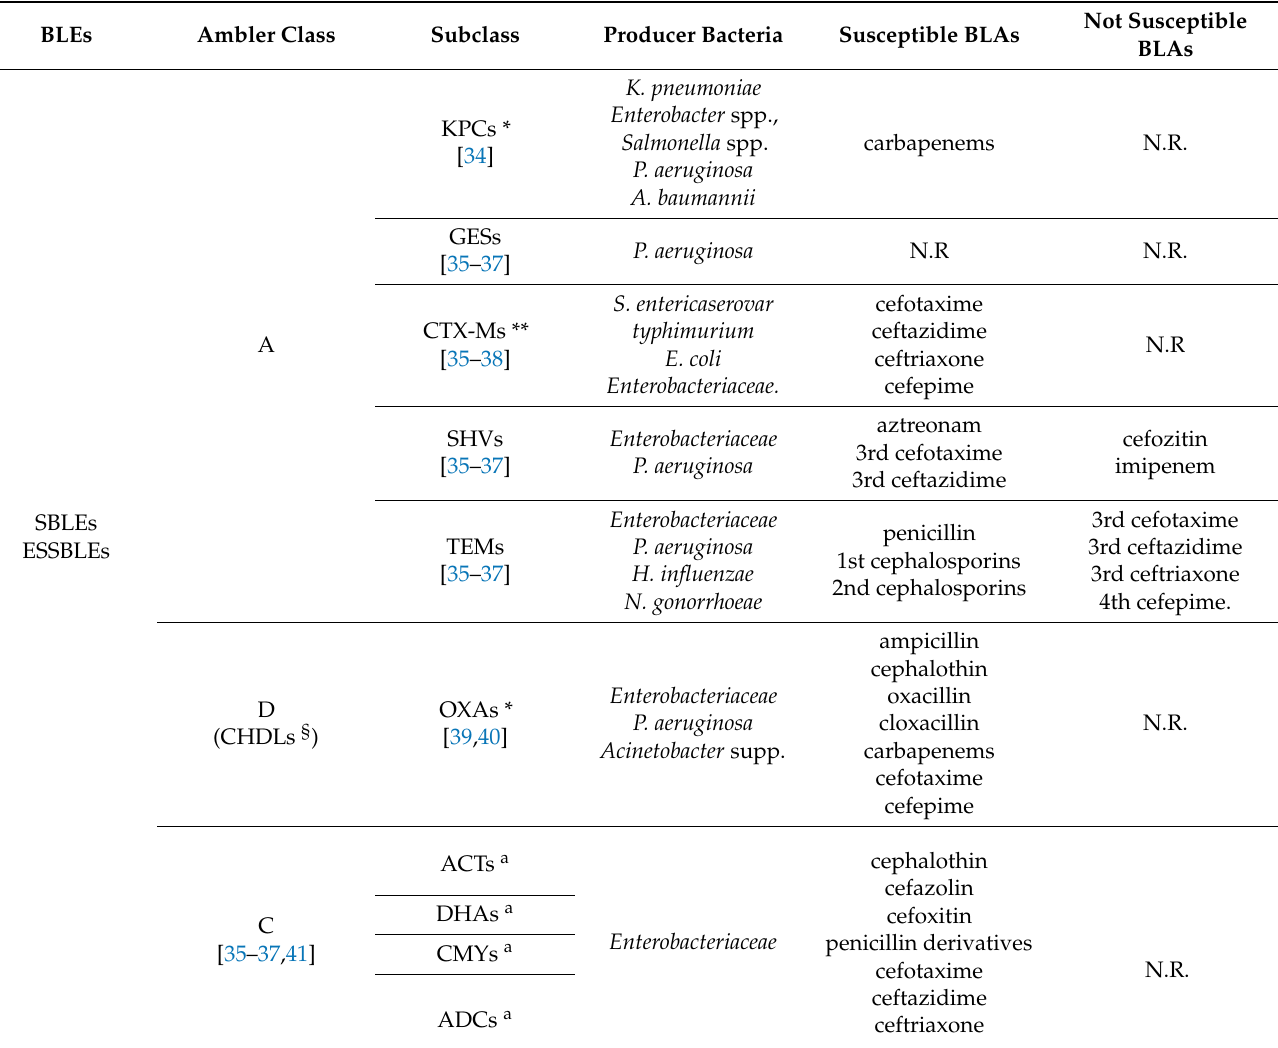
Table 2. The most clinically relevant BLEs grouped according to Ambler classification, the producer bacteria, and the hydrolysed or resistant